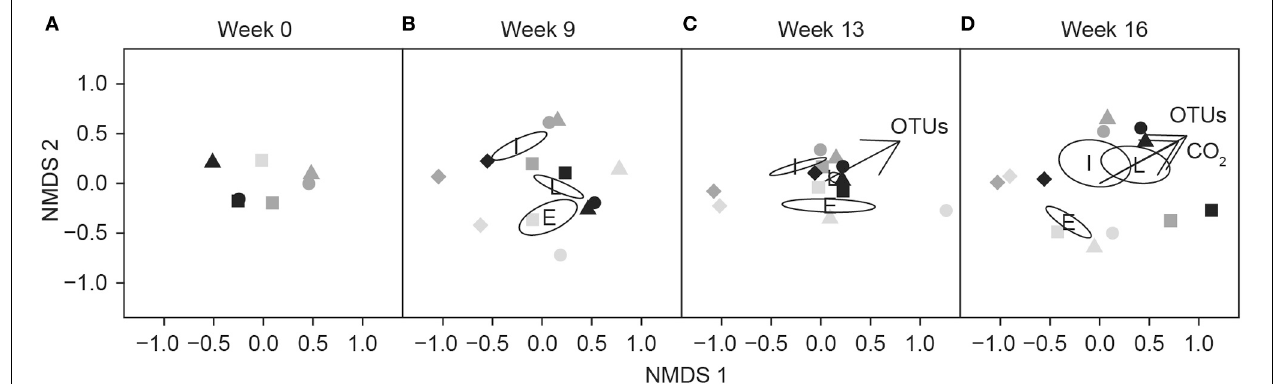
(circles), dilution 10 − 2 g inoculum/g substrate (triangles) and controls (diamonds). The intensity of the symbol indicates the decay stage. Vectors indicate the direction of maximum correlation of CO 2 production and number of OTUs with ordinated samples ( p < 0 . 01). Ellipses indicate the mean location of each decay stage: E, early; I, intermediate; and L,